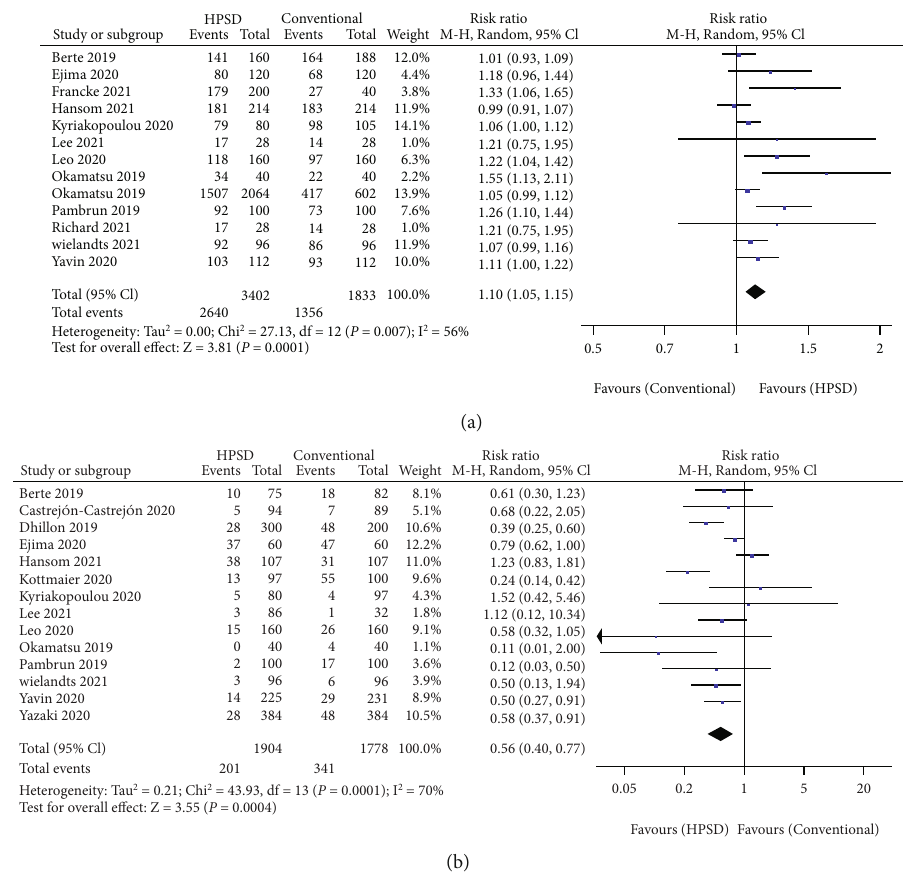
Figure 2: Forest plot of pooled e ff ect demonstrating (a) the fi rst-pass pulmonary vein isolation rate and (b) the acute pulmonary vein reconnection rate of high-power short-duration (HPSD) and conventional ablation settings. 95% CI: 95% con fi dence 95% CI: 0.96-1.17, I 2 = 30 %, and P = 0 : 24 ) (Supplementary